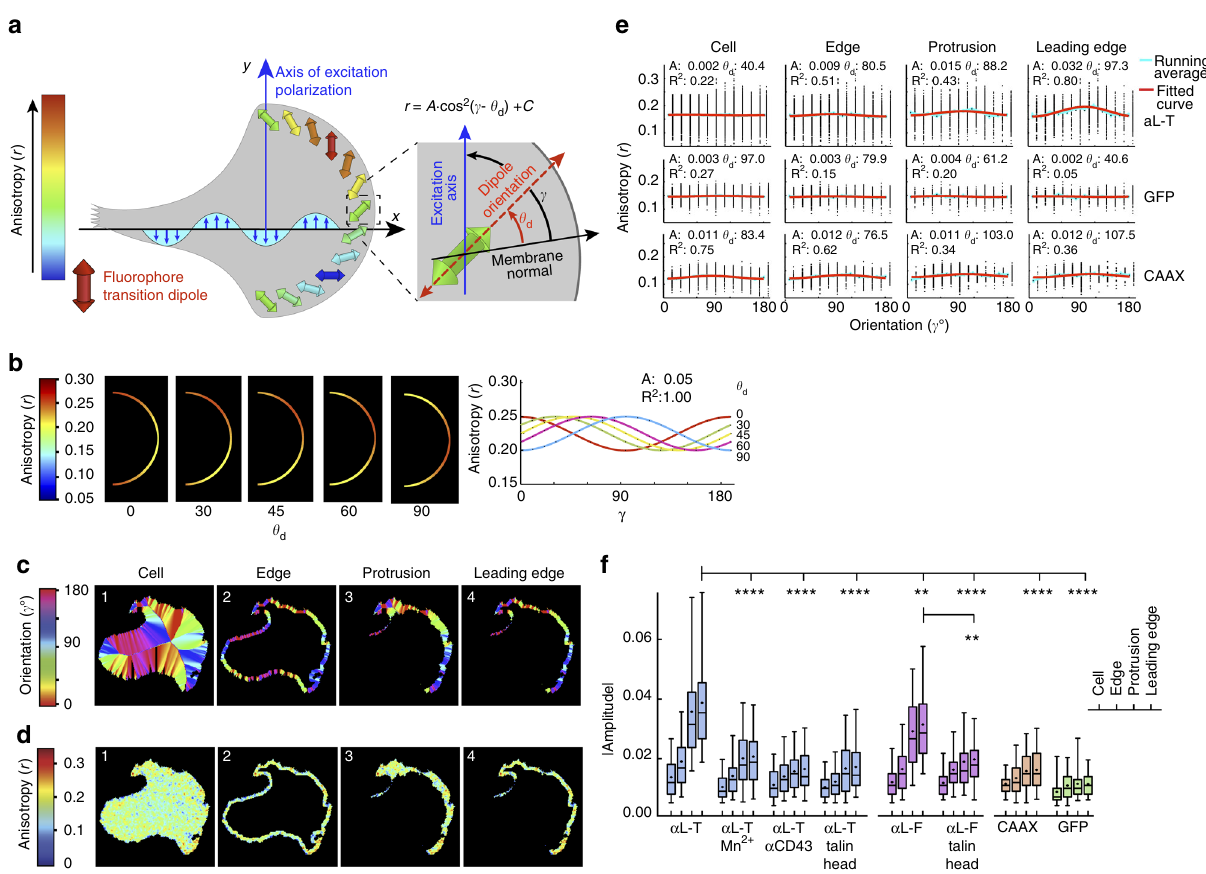
Fig. 4 Orientation of LFA-1 in the leading edge of migrating cells by EA-TIRFM. a Schematic showing relation between excitation polarization orientation, transition dipole orientation, and emission anisotropy in EA-TIRFM. Their quantitative relationship is described by the cos 2 function (inset equation) where r is anisotropy, A is the absolute amplitude of angular dependence and reports the degree of GFP dipole alignment; γ is the angle between the membrane normal and the excitation axis; θ d is the angle between the membrane normal and transition dipole and is equivalent to the phase shift in the cosine function; and C is isotropic background. b Simulation of ability to fi nd a prede fi ned dipole orientation angle relative to membrane normal in an idealized leading edge. Test data were generated with a fi xed amplitude (0.05) and fi ve θ d angles. Left: simulated leading edge images with anisotropy color-coded according to the key. Right: fi tted curves. c , d Representative segmentation (cell, edge, protrusion, and leading edge) of a migrating Jurkat T cell expressing α L-T-GFP with corresponding maps of orientation relative to the cell midline c and anisotropy d in the segmented regions (panels 1 – 4). Scale bar = 5 µ m. e Emission anisotropy of cell, edge, protrusion, and leading edge segments for α L-T, cytosolic GFP, and GFP-CAAX (Supplementary Figs. 5 – 8) fi t to the cos 2 function. Plots show anisotropy vs. orientation relative to the cell midline for each pixel in individual, representative cells (from c and d for α L-T), the running average (blue) and fi t (red). Values for the fi t parameters ( A = absolute amplitude, θ d = phase shift, R 2 = goodness-of- fi t) are displayed in each plot. f Absolute amplitudes of emission anisotropy fi ts to the cos 2 relationship. Box plots show the full range (whiskers) of observations with median as line and 5 – 95 percentile range boxed. Kruskal – Wallis test with multiple comparison correction to α L-T leading edge data ( N = 206) gave P values from left to right: < 0.0001 ( N = 85); < 0.0001 ( N = 52); < 0.0001 ( N = 58); 0.0033 ( N = 185); < 0.0001 ( N = 71); < 0.0001 ( N = 83); < 0.0001 ( N = 55) with N leading edges. See Supplementary Table 3 for more details. A two-tailed Mann – Whitney test of α L-F in absence and presence of talin head gave a P value